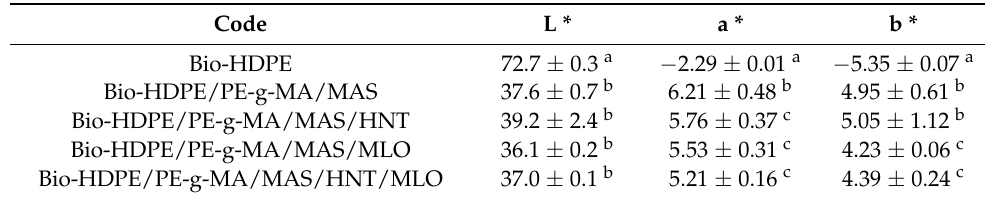
Table 6. Luminance and color coordinates (L*a*b*) of the Bio-HDPE/PE-g-MA/MAS blends with different compatibilizers.